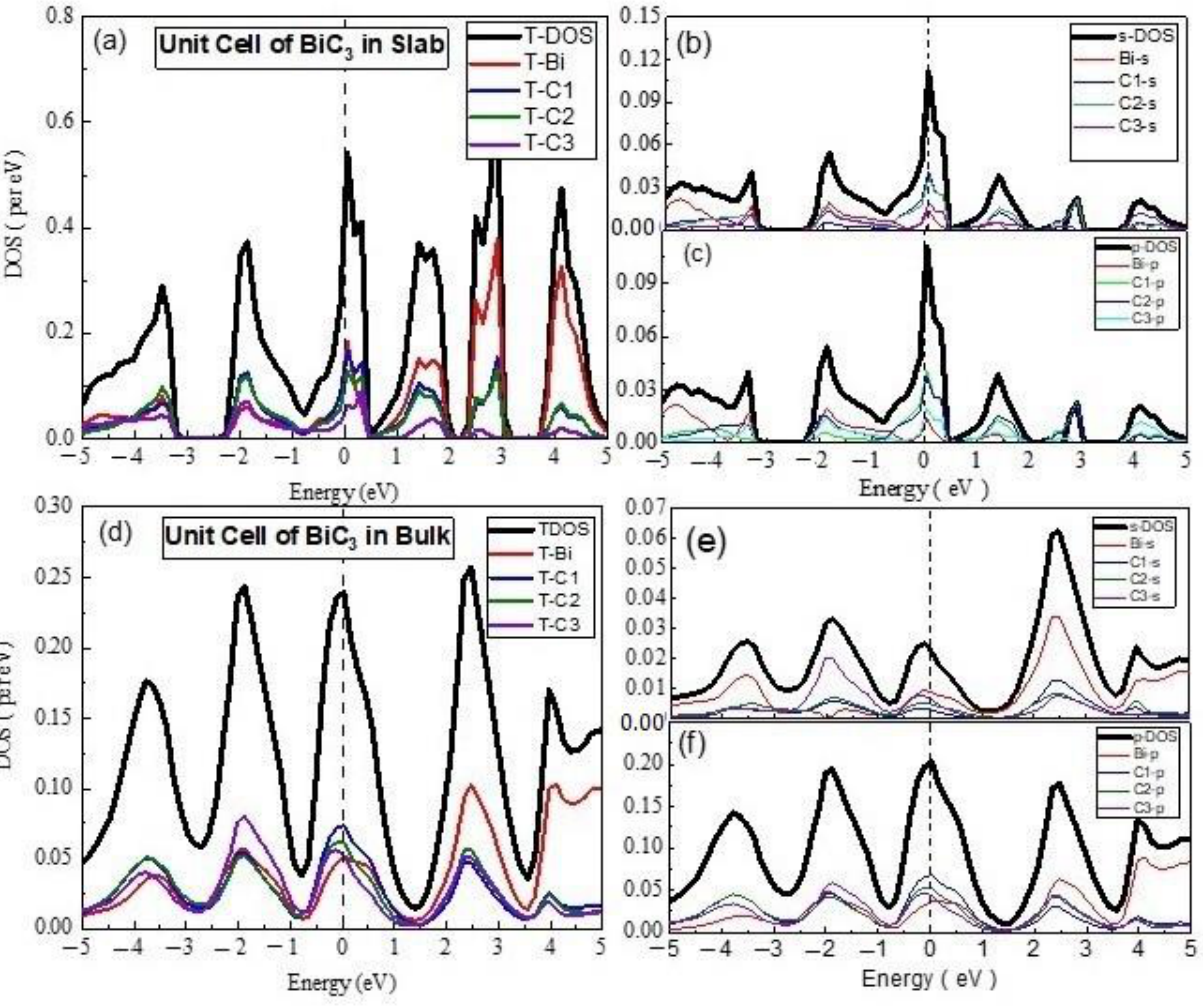
Figure 6. The calculated total density of states (TDOS) and partial density of states for mentioned atoms in BiC 3 unit cell ( a ) TDOS of slab ( b ) s-DOS of slab ( c ) p-DOS of slab ( d ) TDOS of bulk ( e ) s-DOS of bulk ( f ) p-DOS of bulk. The Fermi level was adjusted at 0 eV.